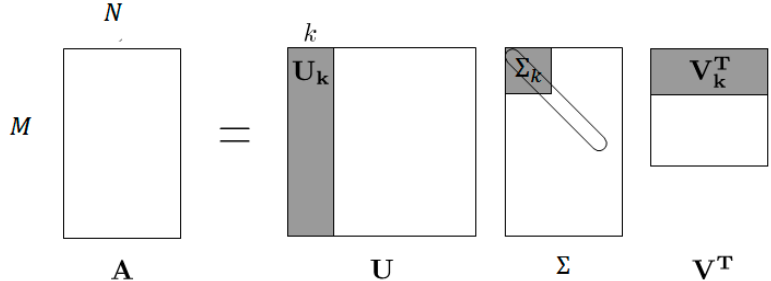
Figure 5. The singular value decomposition (SVD). Each singular value in S has an associated left singular vector in U and right singular vector in V .